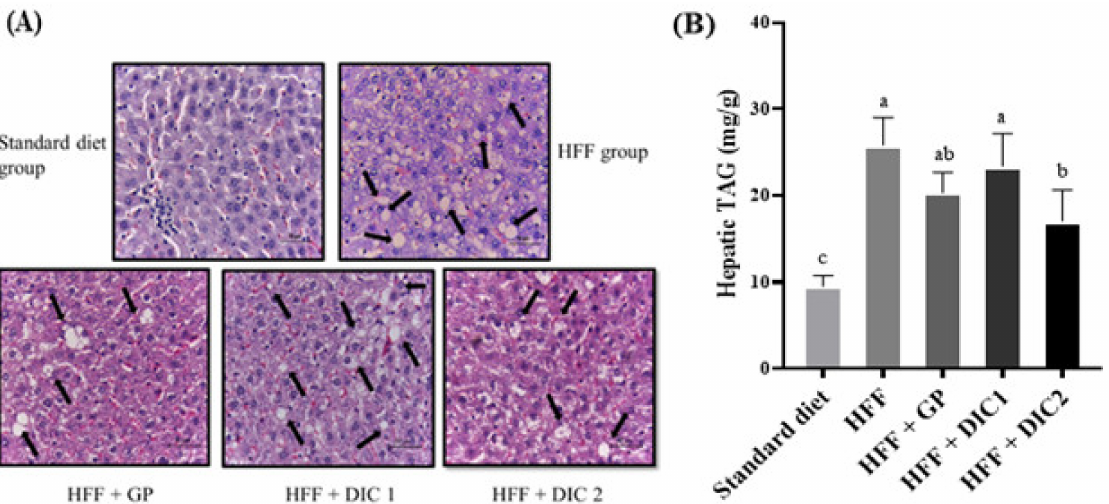
Figure 3. ( A ) Representative liver histological micrographs. ( B ) Hepatic triacylglycerols (mg/dL) of rats fed a high-fat–fructose (HFF) diet supplemented or not with grape pomace subjected or not to DIC. Data are reported as means ± SEs for eight animals per group. Different letters indicate significant differences between the groups. Statistically significant differences were determined by ANOVA, followed by Tukey’s test ( p < 0.05). GP, grape pomace without DIC; DIC1, grape pomace with DIC at 0.2 MPa for 60 s; DIC2, grape pomace with DIC at 0.4 MPa for 120